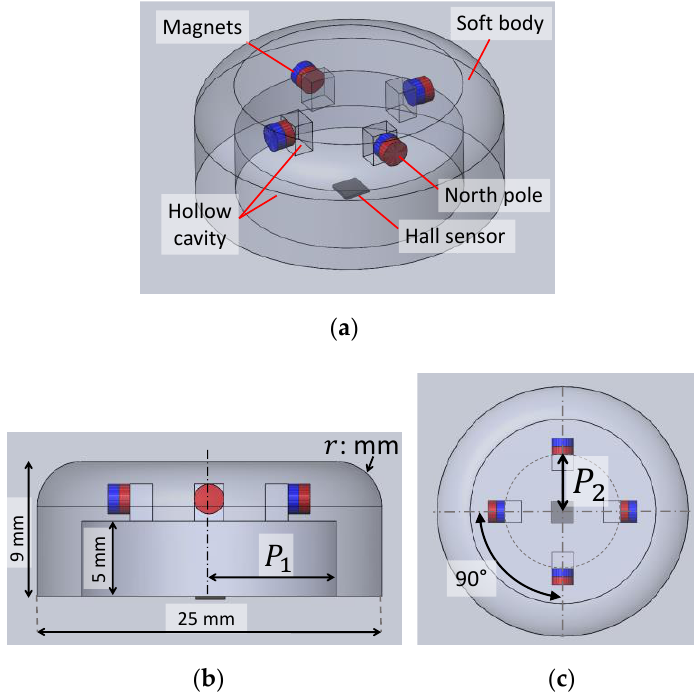
Figure 4. Intuitive fingertip design: ( a ) isometric view, ( b ) side view with parameter P 1 indicating hollow radius, and ( c ) top view with parameter P 2 indicating the magnet position.